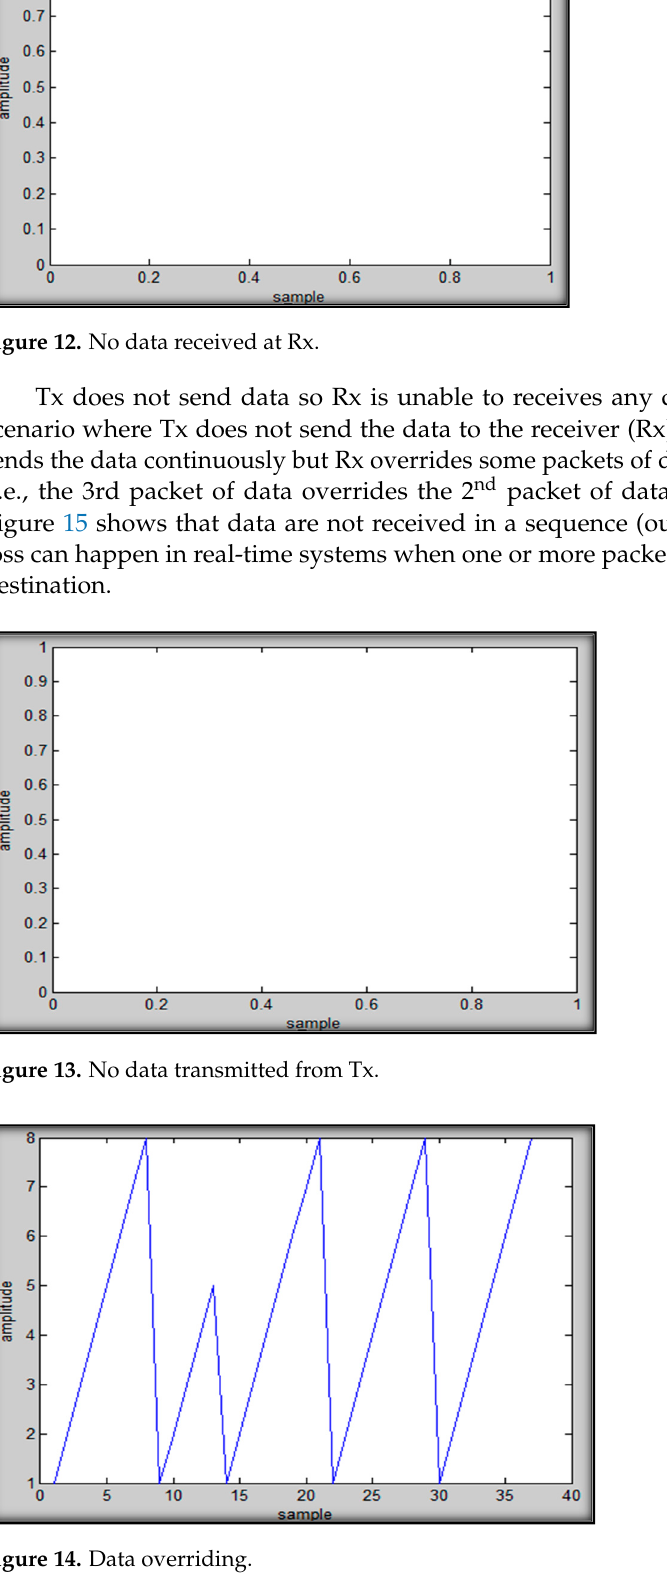
Figure 15. No synchronization. Synchronization bugs were also simulated in code composer studio software to vali- date the proposed approach. The results are shown in Figure 16.